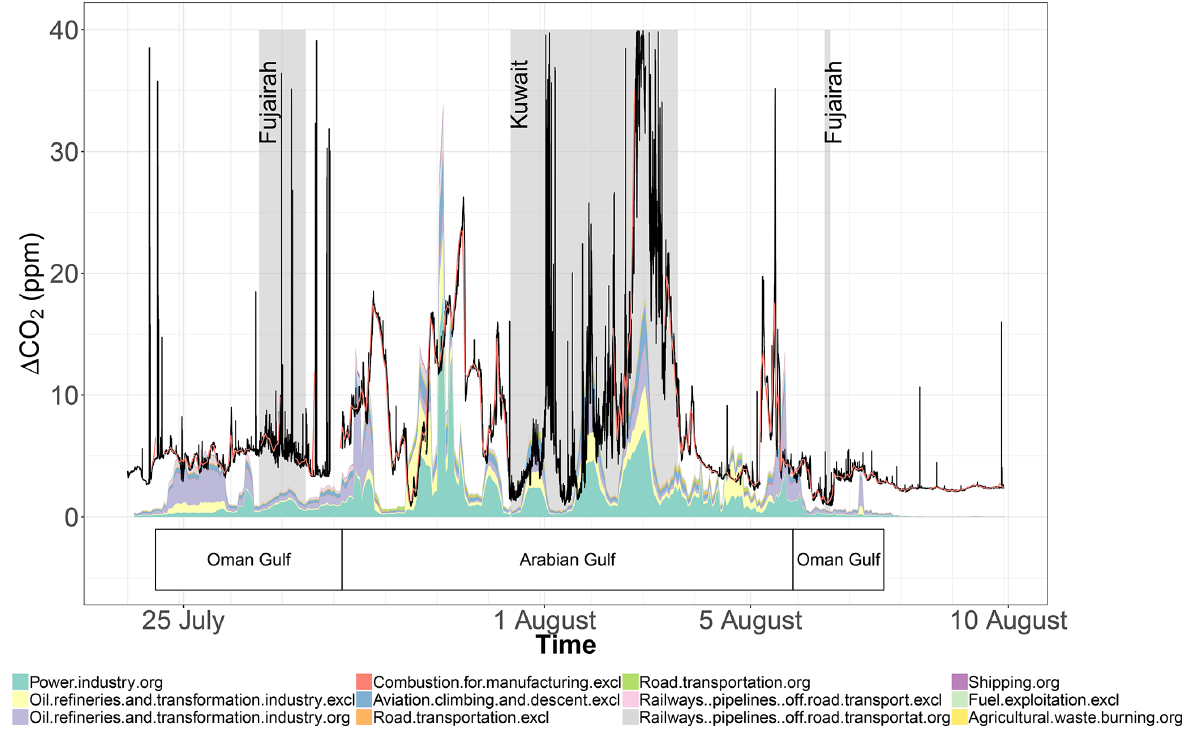
Figure 9. Comparison of simulated excess CO 2 time series at the receptor position in the Gulf of Oman and Arabian Gulf and hourly average (cid:49) CO 2 measured from the ship (black line). Flagged, hourly average data are shown in light red. The simulation combines FLEXPART potential emission sensitivity and the EDGAR inventory (stacked areas). The main source sectors are indicated using a color code. The stops at each harbor are indicated as shaded gray areas, with the names of the harbors indicated at the top.